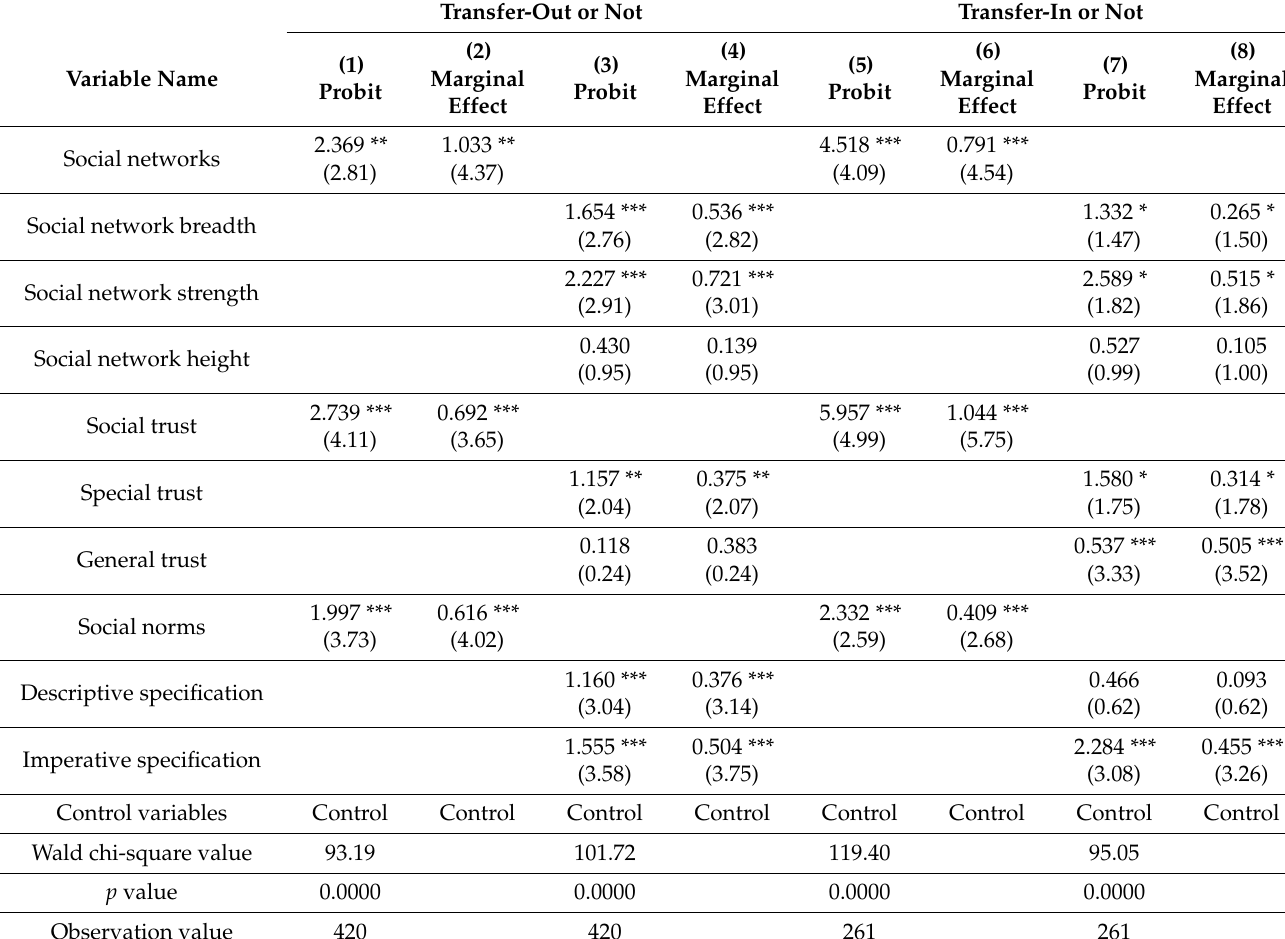
Table 8. Estimation results of the sample model in the Jianghan plain area. Transfer-Out or Not Transfer-In or Not